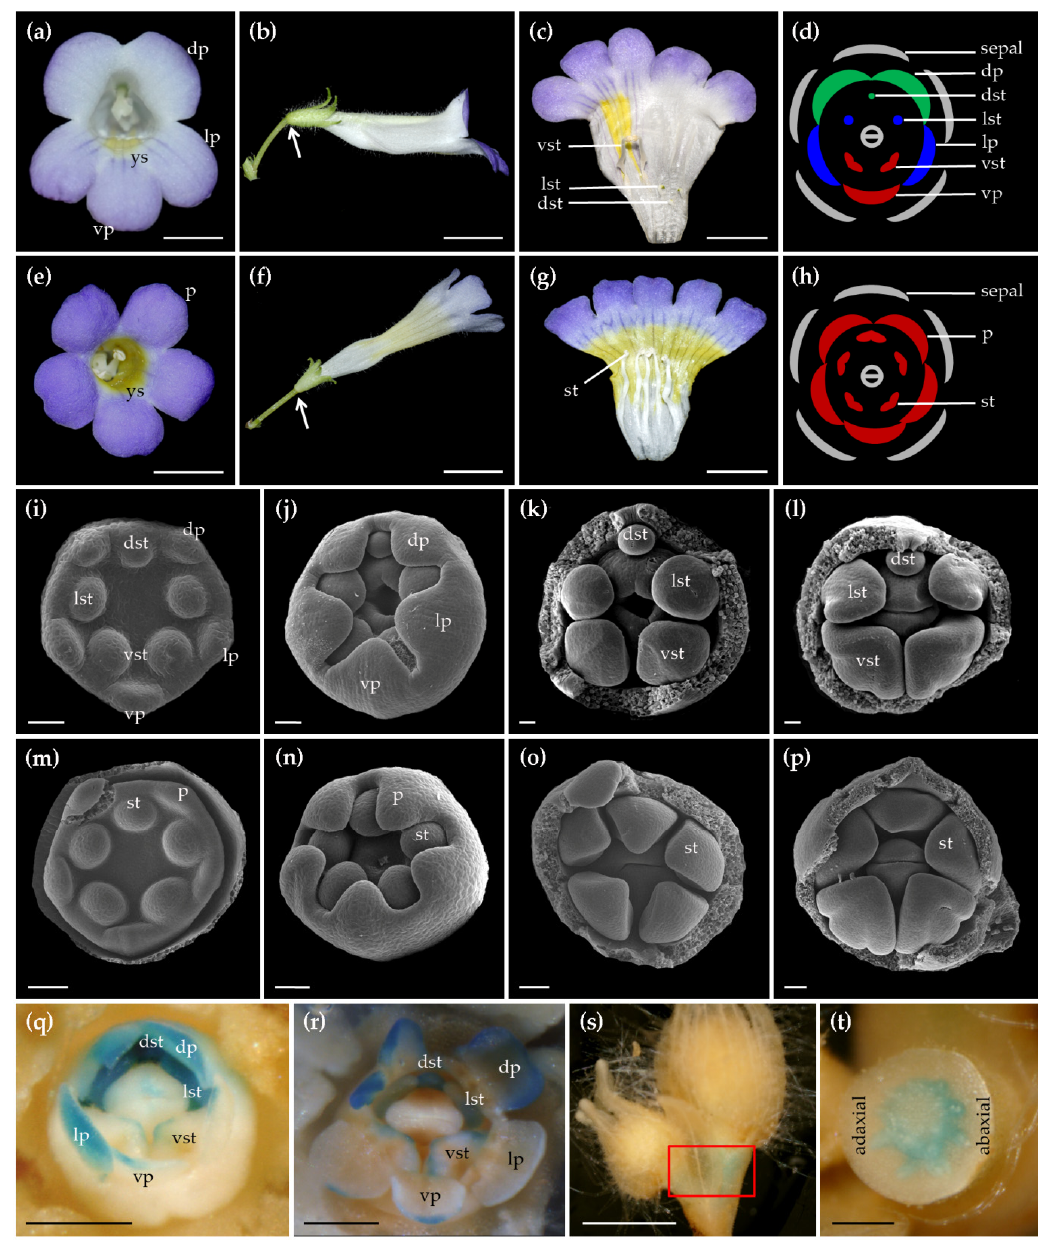
Figure 7. Phenotypic analyses of transgenic plants carrying RNAi:CpCYC . ( a ) The front view of a wild type zygomorphic flower showing three different types of petals along the dorsoventral axis and characteristic yellow spots in the ventral corolla tube. ( b ) The lateral view of the wild type flower. ( c ) A dissected flower with both dorsal and lateral stamens aborted and only two fertile ventral stamens. ( d ) Floral diagram of wild type zygomorphic flowers. ( e ) The front view of an actinomorphic transgenic flower with five identical petals and expansion of yellow spots all over the internal surface of corolla tube. ( f ) The lateral view of the transgenic flower. ( g ) The dissected transgenic flower showing five fertile stamens and expanded yellow spots. ( h ) Floral diagram of actinomorphic transgenic flowers. White arrows in panels ( b , f ) show the different orientation of wild type and transgenic mutant flowers. ( i – l ) Early development of wild type flowers showing the retardation of dorsal and lateral stamen primordia relative to the ventral ones. ( m – p ) Early development of RNAi:CpCYC plants showing synchronous development of all stamens giving rise to five fertile stamens. ( q , r ) GUS signals were detected mainly in dorsal petals as well as dorsal and lateral staminodes. ( s ) GUS signals were detected mainly in the pedicel (red rectangle) with a dorsoventrally asymmetric pattern. ( t ) The transverse image of the pedicel in ( l ). dp/lp/vp, dorsal/lateral/ventral petals; dst/lst/vst, dorsal/lateral/ventral stamens; p, petals; st, stamens; ys, yellow spots. Scale bars: 0.5 cm in panels ( a – c , e – g , q – s ); 50 µ m in panels ( i – p ); 1 mm in panel ( t